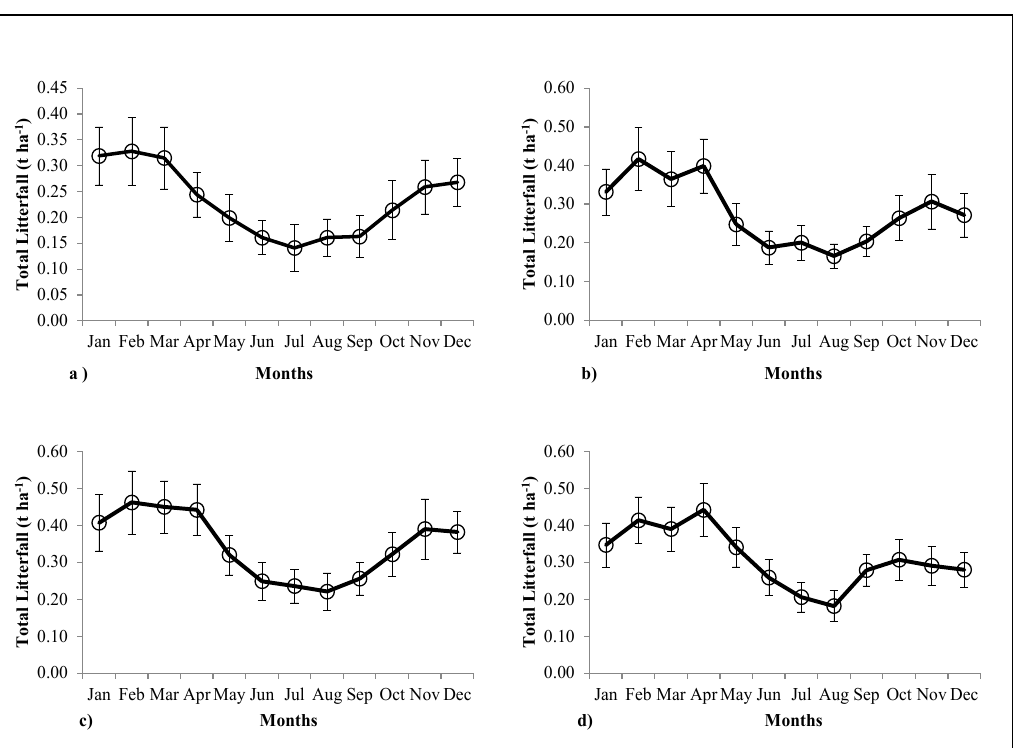
Figure 4. Total litterfall (Mg ha − 1 ) of M. composita plantation of different ages: ( a ) 4 years old; ( b ) 5 years old; ( c ) 6 years old; ( d ) 7 years old. The highest C stock was 68.94 in 7-year-old M. composita with the highest contribu- tion of bole of 43.34 Mg C ha − 1 . The percent distribution of bole, branches, twigs, foliage, stump root, lateral roots, and fine roots was 62.9%, 11.0%, 3.7%, 5.2%, 10.7%, 5.4%, and 1.0%, respectively. The mean total carbon stock ranged from 32.71 to 42.95 Mg ha − 1 in the